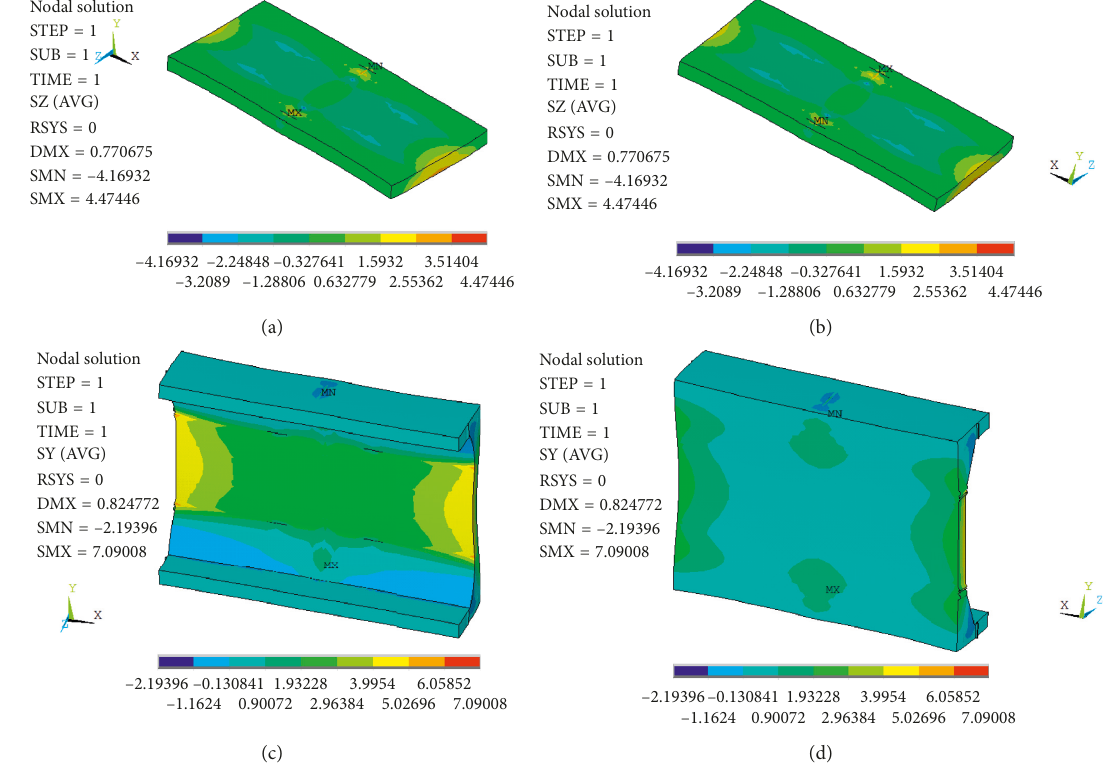
Figure 8: Stress distribution in bottom of the slab and web of the arch rib after 180 days’ shrinkage (unit: MPa). Normal stress distribution in Z -direction on (a) the inner surface of the bottom slab and (b) the outer surface of the bottom slab. Normal stress distribution in the Y -direction on (c) the inner surface of the web and (d) the outer surface of the web.